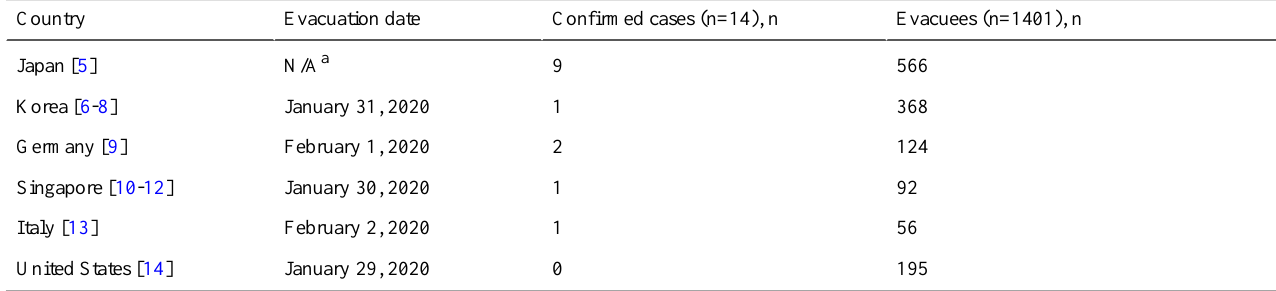
Table 1. Number of infected people from different countries.